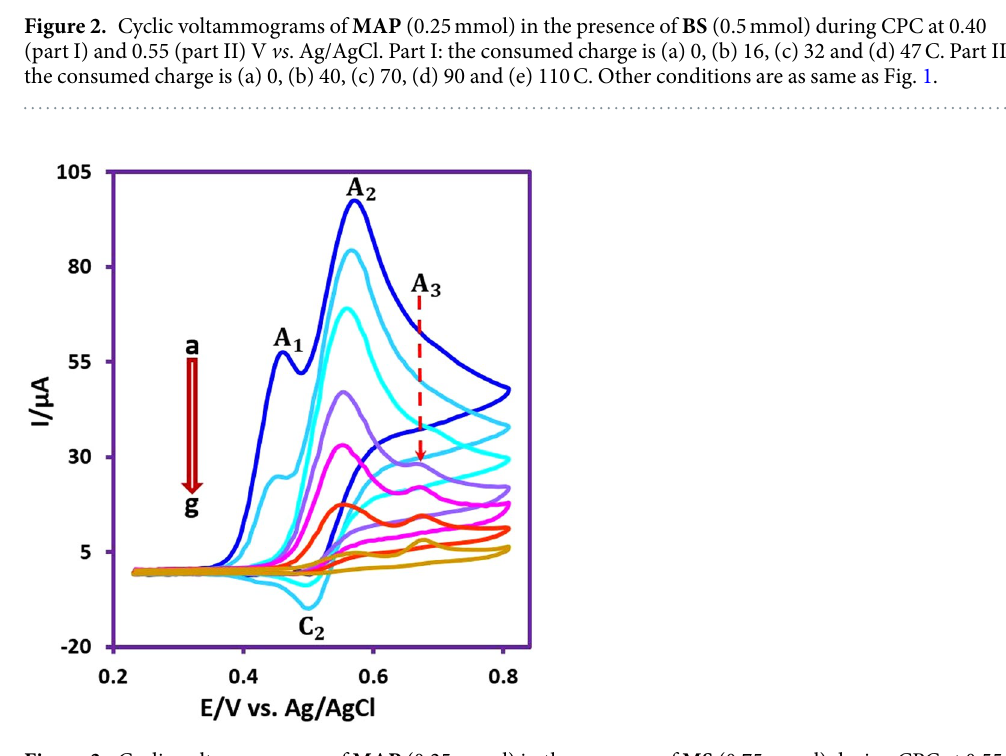
Figure 3. Cyclic voltammograms of MAP (0.25 mmol) in the presence of MS (0.75 mmol) during CPC at 0.55 V vs. Ag/AgCl, after consumption of (a) 0, (b) 35, (c) 75, (d) 105, (e) 120, (f) 135 and (g) 151 C. Other conditions are as same as Fig.